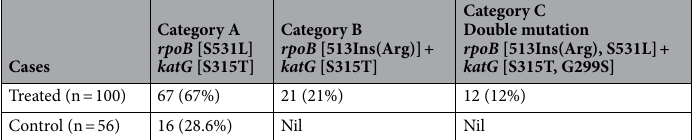
Table 1. Total number of multiple drug resistant cases in treated and control groups.